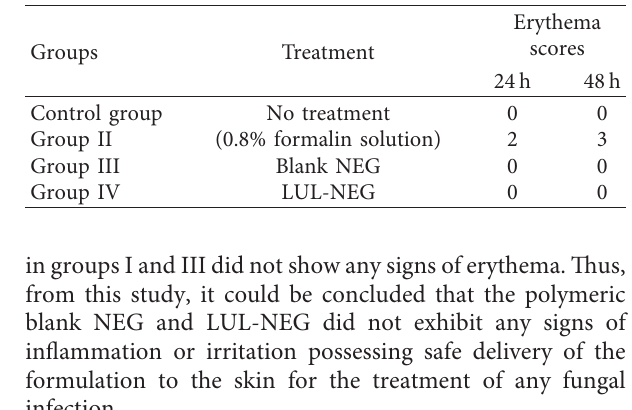
Table 3: Erythema/oedema scores of the skin in treated animals after 24 and